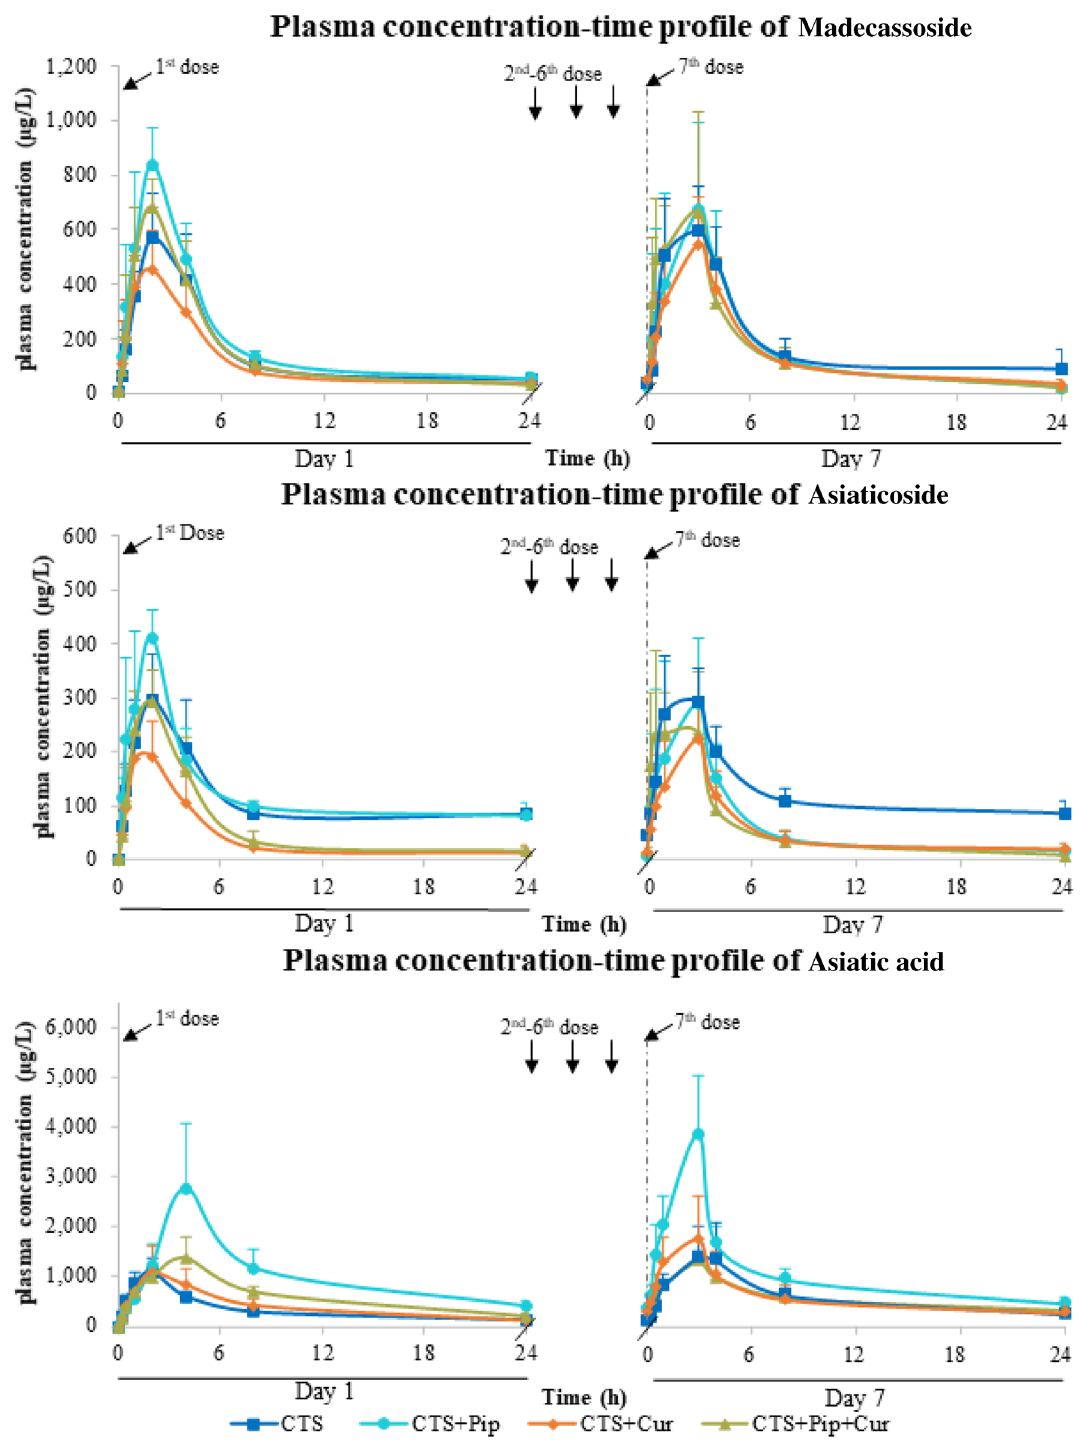
Figure 2. Plasma concentration–time profiles of major bioactive triterpenoids from Centella asiatica extract alone and in combination with curcumin and/or